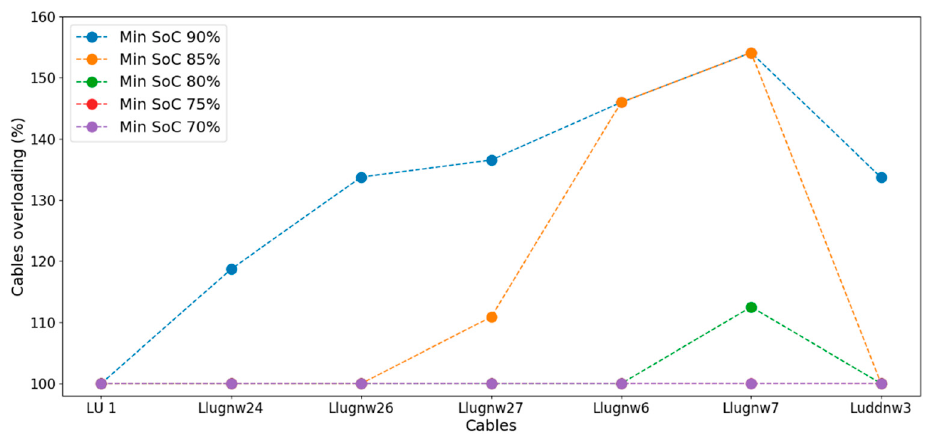
Figure 8. Cables’ overloadings at 5 p.m. for different minimum SoC values for discharging.